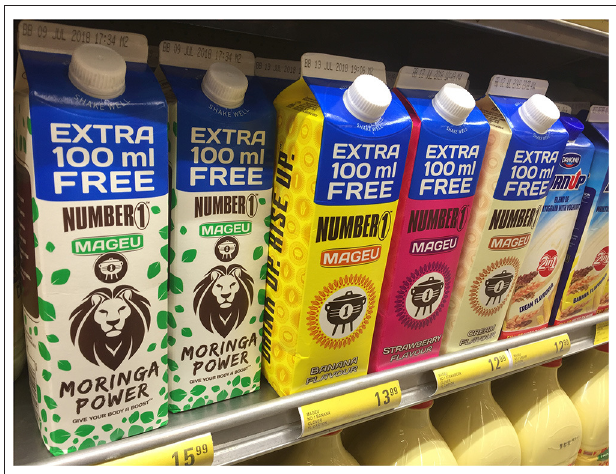
FIGURE 6 | Images of Mageu in a variety of